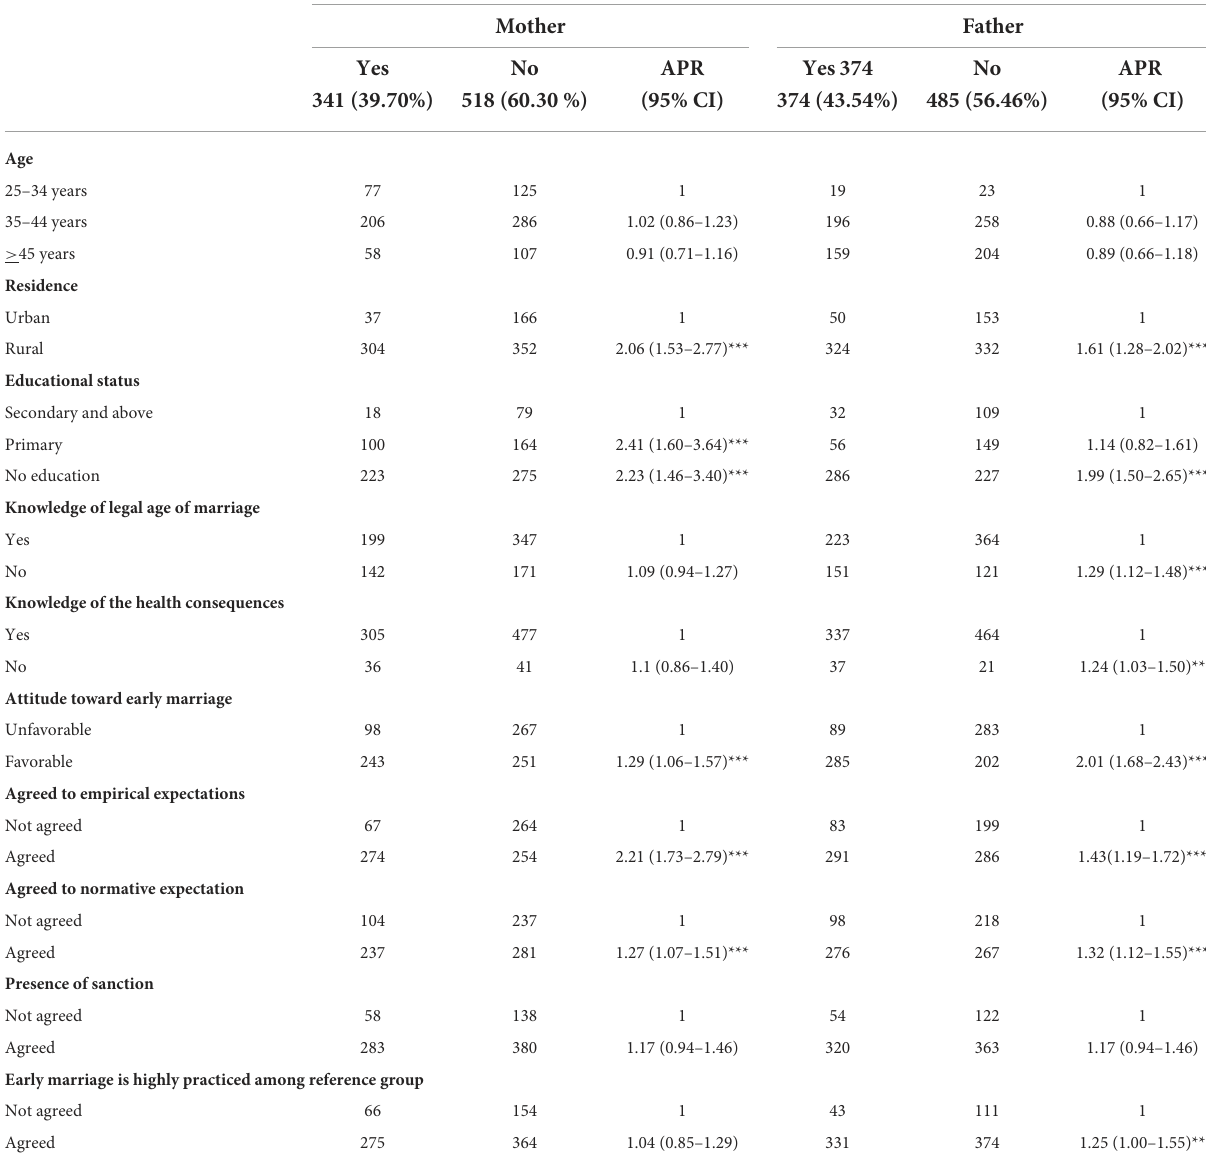
TABLE 4 Factors associated with intention of parents to early marriage living in Kersa HDSS, Eastern Ethiopia, 2019.